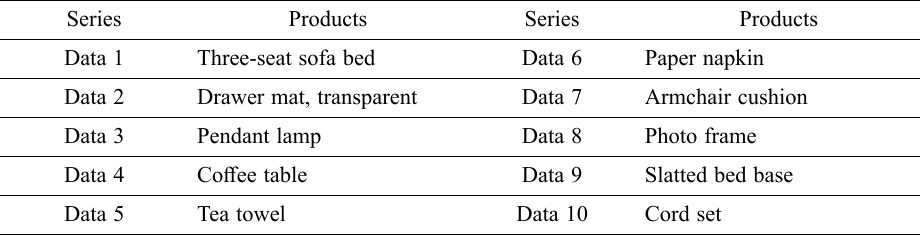
Table 2. Description of the series under